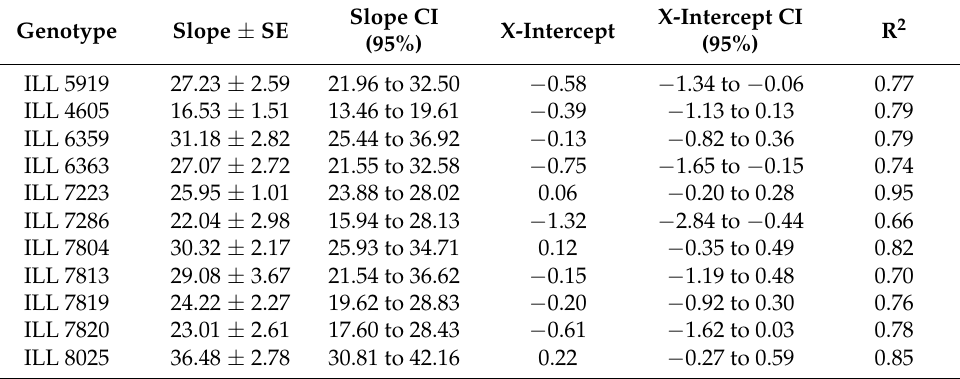
Table 5. Results of the 11 genotypes exhibiting single linear regression fits of TR response to vapor pressure deficit. The table includes slope with standard error (SE), X-intercept and R 2